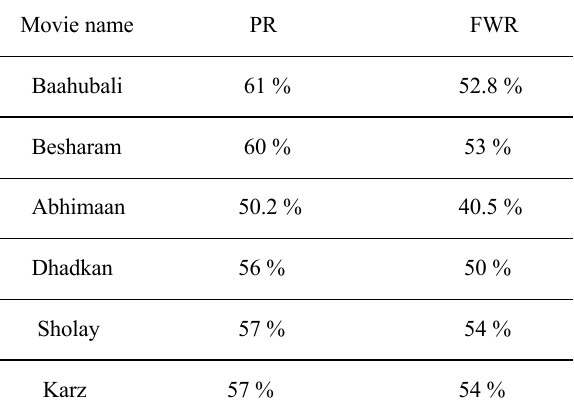
Table 8: Comparisons of fixations at left AOI_SLS_Left